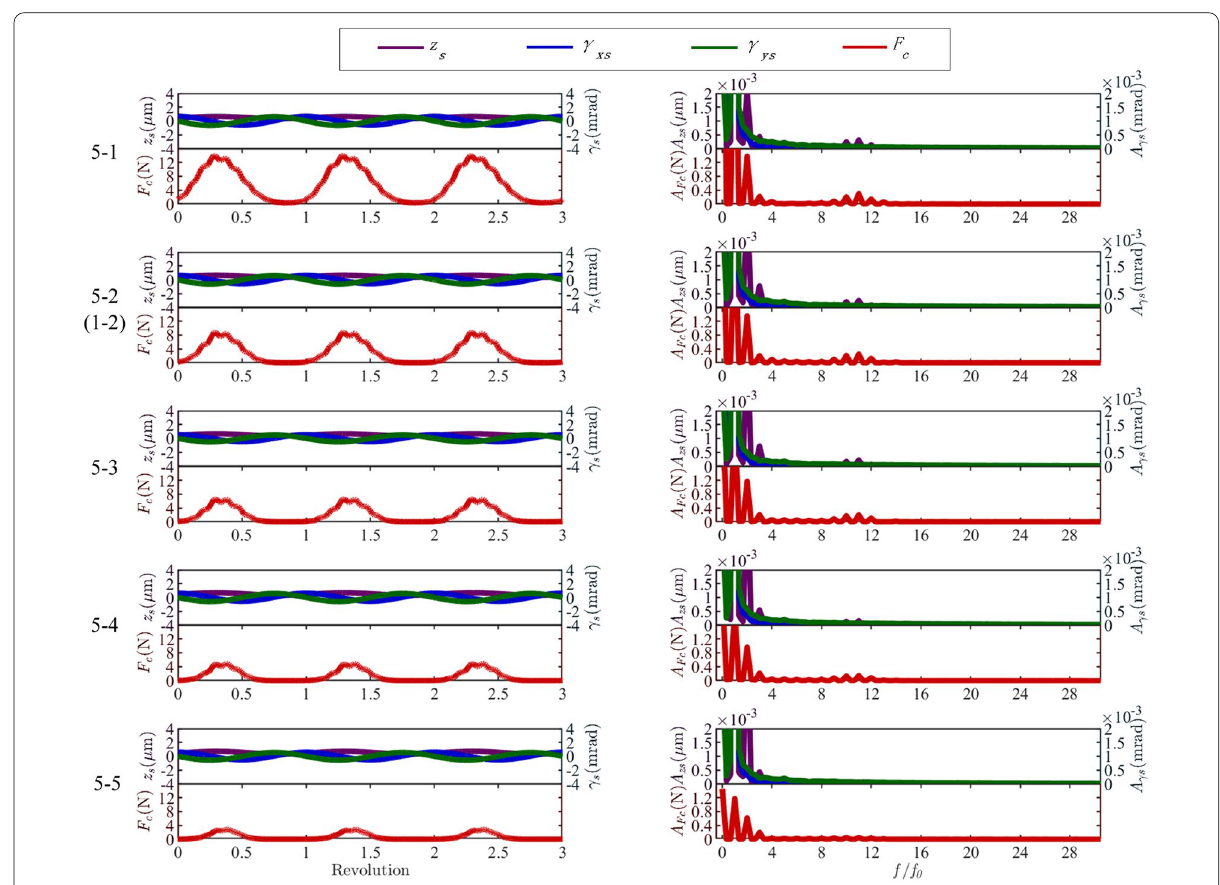
Figure 8 Results of Group